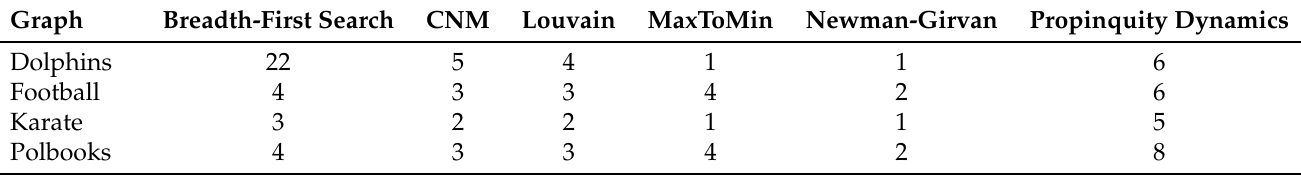
Table 4. Number of